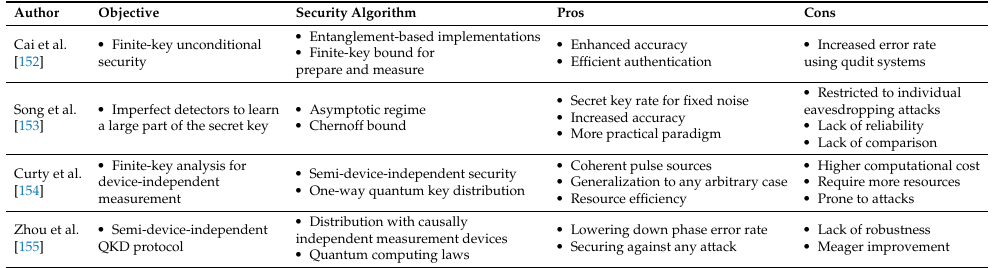
Table 7. Summary of countermeasures and security protocols using Finite-Key Analysis